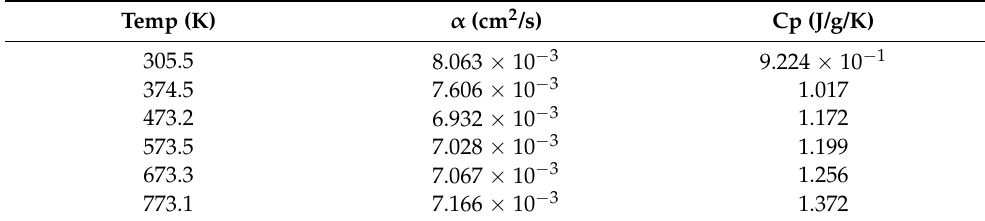
Table 1. Thermal diffusion coefficient and specific heat capacity of C12A7 electride at different